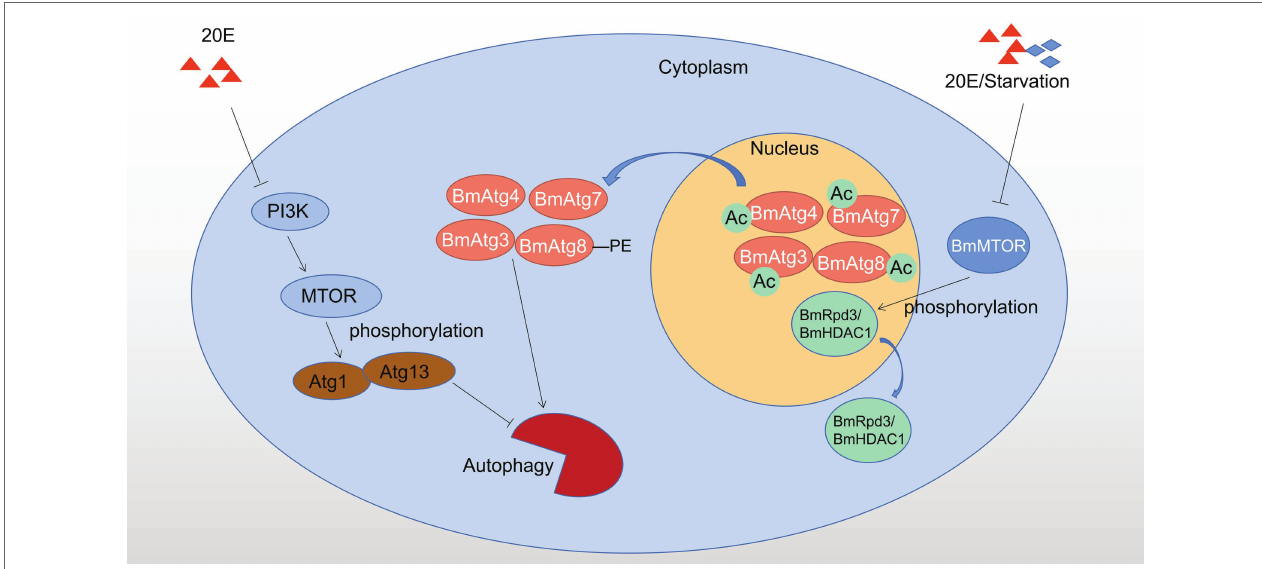
FIGURE 2 | Autophagy regulated by phosphorylation and acetylation in Bombyx mori and Drosophila melanogaster . 20E affects the phosphorylation status of Atg1-Atg13 complex by inhibiting PI3K-MTOR activity to induce autophagy; 20E or starvation signal causes dephosphorylation of BmRpd3/ BmHDAC1, which subsequently leads to deacetylation and nucleo-cytoplasmic translocation of the molecular components from BmAtg8 -PE ubiquitin-like protein system, thereby promotion of autophagy, Ac: acetylation. Red triangles indicate 20E; blue rhombuses indicate